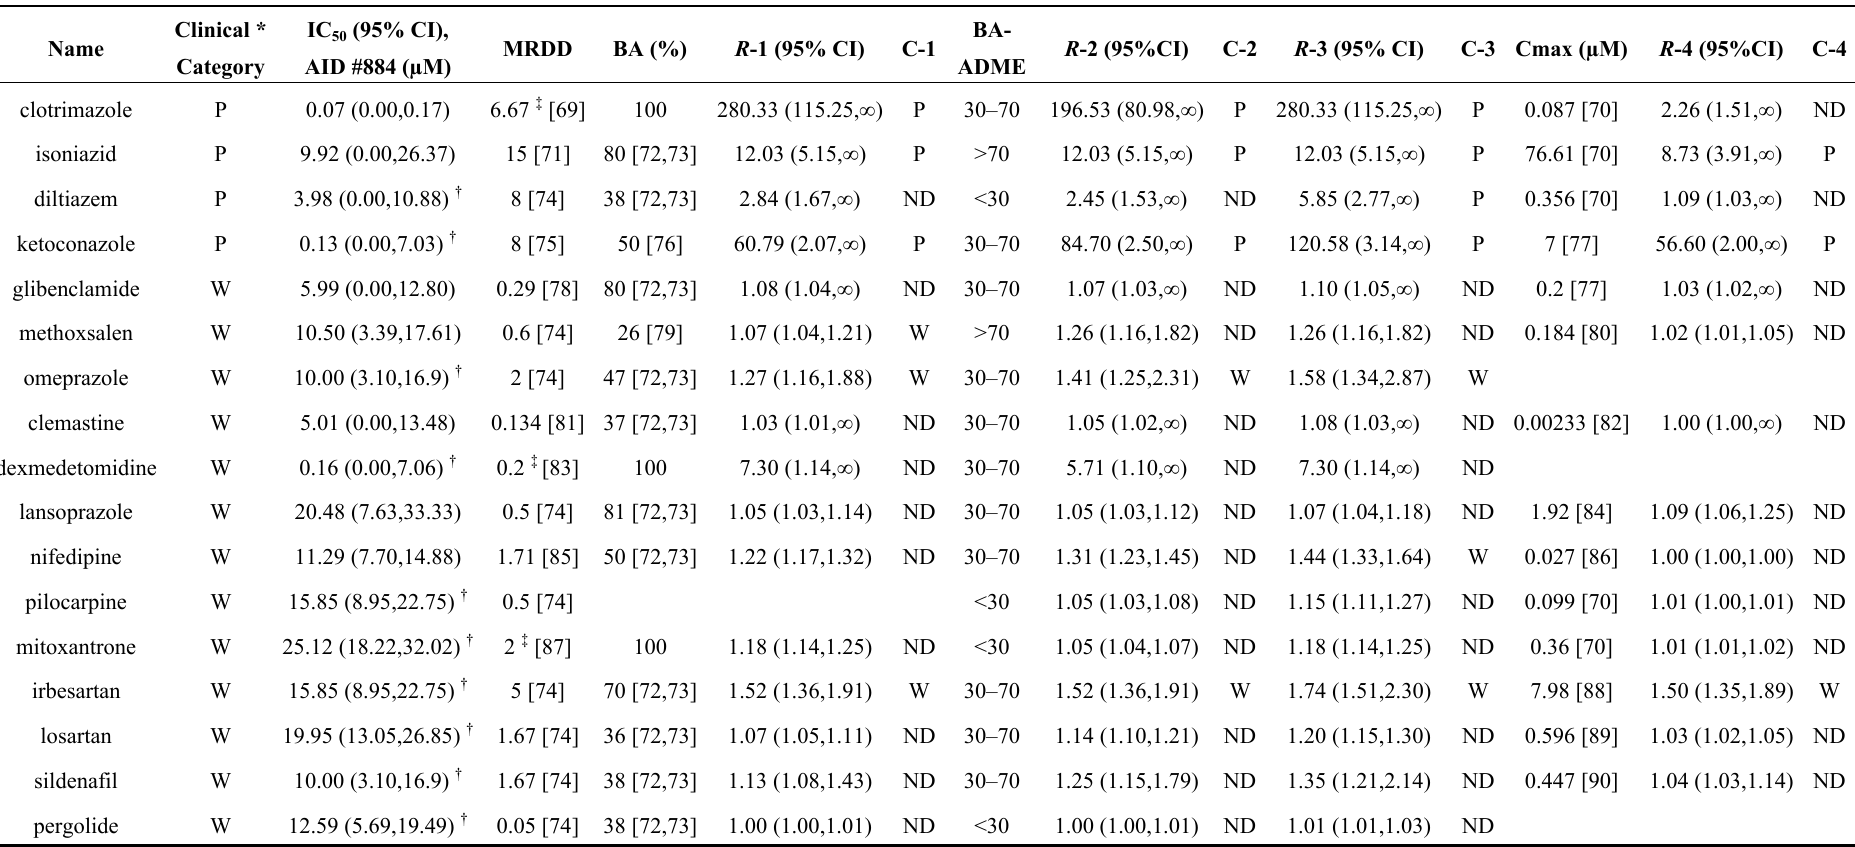
Table 1. Extrapolation from in vitro bioassay to in vivo pharmacokinetic CYP3A4 inhibition data, and data